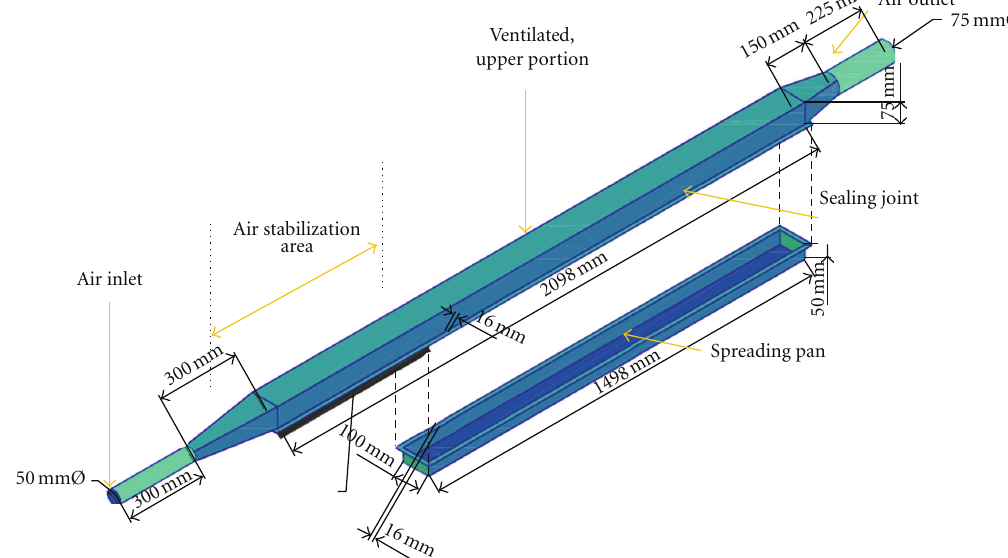
Figure 1: Wind tunnels used for the laboratory manure land application simulations to measure NH 3 volatilization. The wind tunnel is set on a spreading pan holding 50mm of experimental soil. Fresh air is introduced through the bottom left hand pipe, circulated through the body at a speed of 3ms − 1 and exited through the top right hand pipe. To measure NH 3 volatilization, a known portion of the outlet air was bubbled through an acid